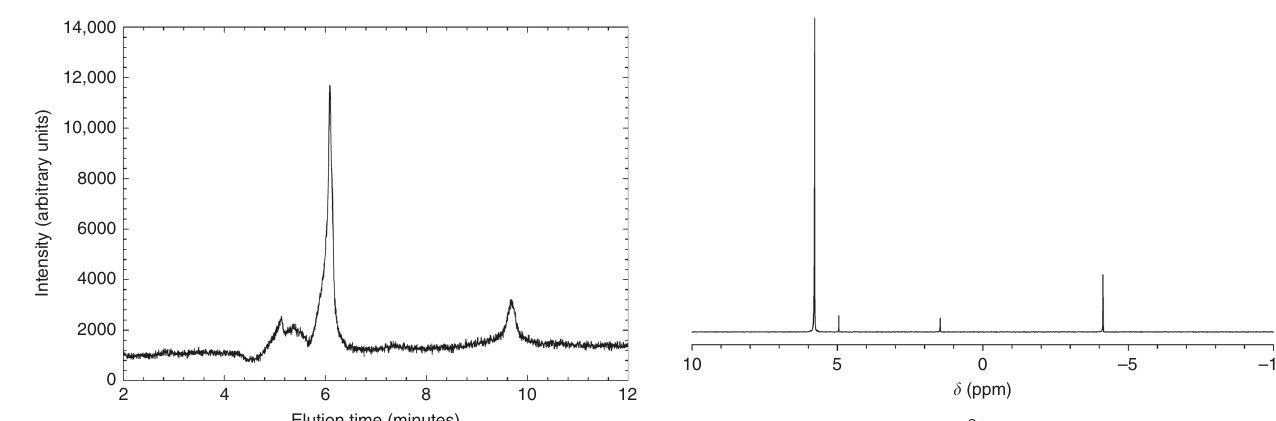
Fig. 2 NMR spectrum of heated Fe 2 + and phosphate solution. Proton- coupled 31 P NMR of a solution of FeCl 2 and Na 2 HPO 4 heated to dryness (180 °C), under fl owing N 2 . All compounds are references to an external standard of 85% H 3 PO 4 (0 ppm, as a frequency spectrum referenced to H 3 PO 4 at 161.9 MHz). Phosphate is at 5.8 ppm, and pyrophosphate (HP 2 O 7 3 − ) is at − 4.2 ppm. The small doublet at 4.95 and 1.46 ppm corresponds to phosphite (4% of total area), identi fi ed by its large H – P J- coupling constant of 565 Hz